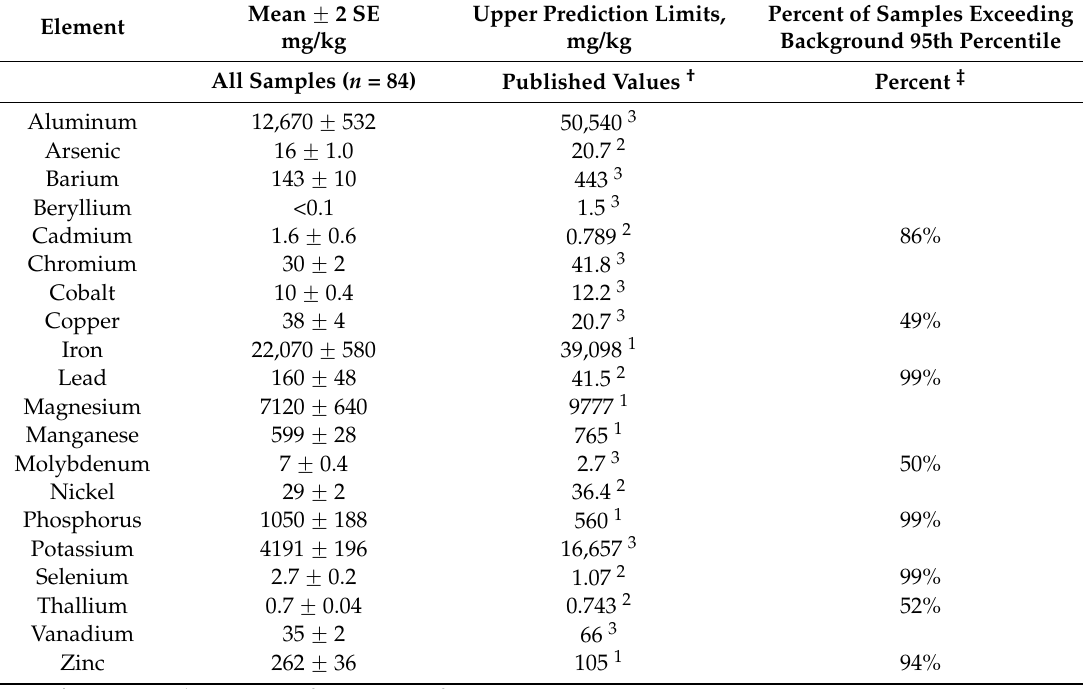
Comparison between metal concentrations in Stambaugh-Elwood soil versus published